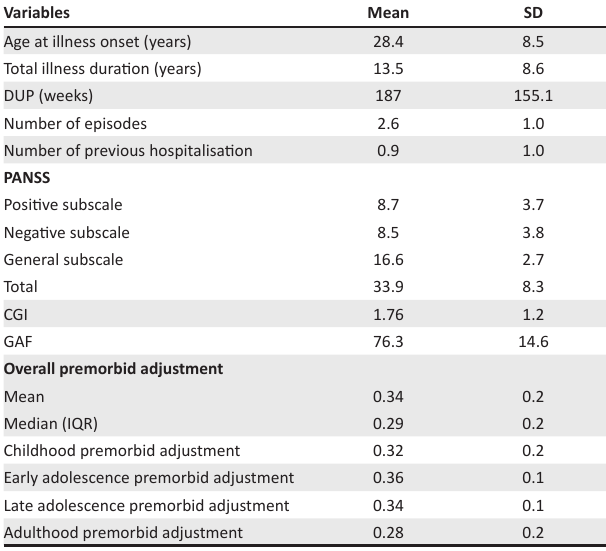
TABLE 2: Clinical characteristics of the